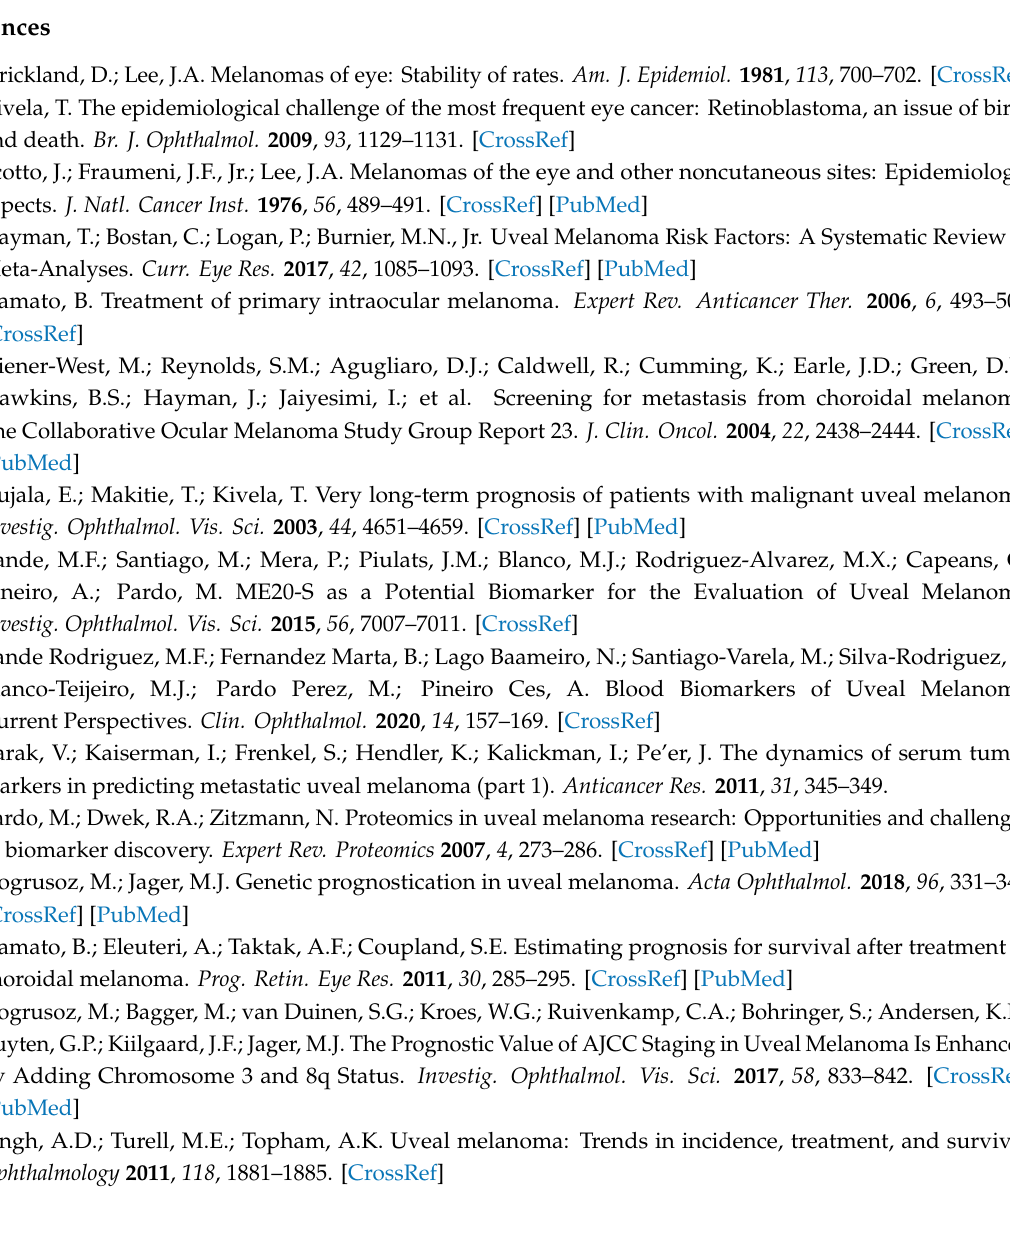
Table S1. Included studies of conventional chemotherapy; Table S2. Included studies of chemoimmunotherapy; Table S3. Included studies of intra-arterial liver chemotherapy (ILC); Table S4. Included studies of transarterial liver chemoembolization (TACE); Table S5. Included liver perfusion isolation studies (IHP); Table S6. Included studies of immunotherapy; Table S7. Included targeted therapy studies; Table S8. Included liver radioembolization studies; Table S9. Included immunoembolization studies; Table S10. Included studies of immunosuppression; Table S11. Included studies of thermotherapy directed at the liver; Table S12. Included dendritic cell vaccine studies; Table S13. Included studies of CIOVIR-5 oncolytic adenovirus; Table S14. Included studies of surgical